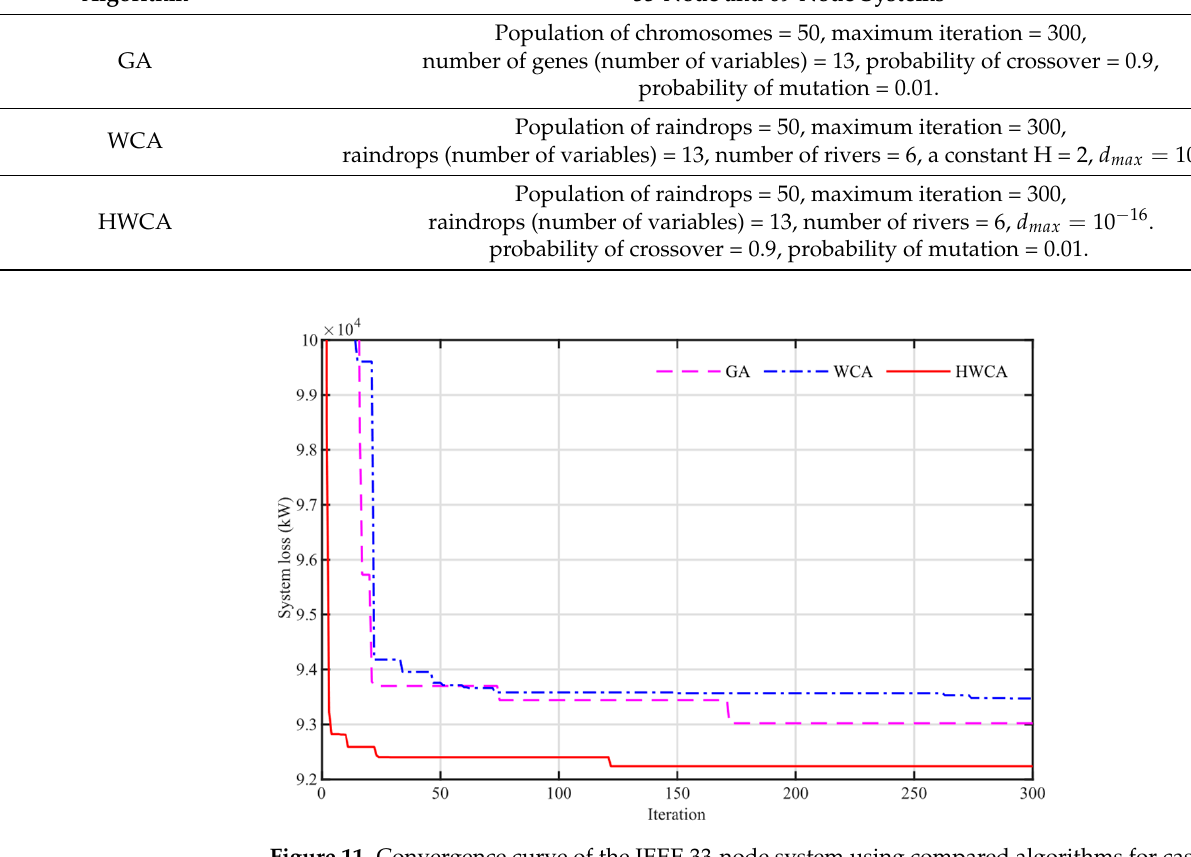
Table 7. Optimization parameter settings of GA, WCA, and HWCA for cases 6 and 7.